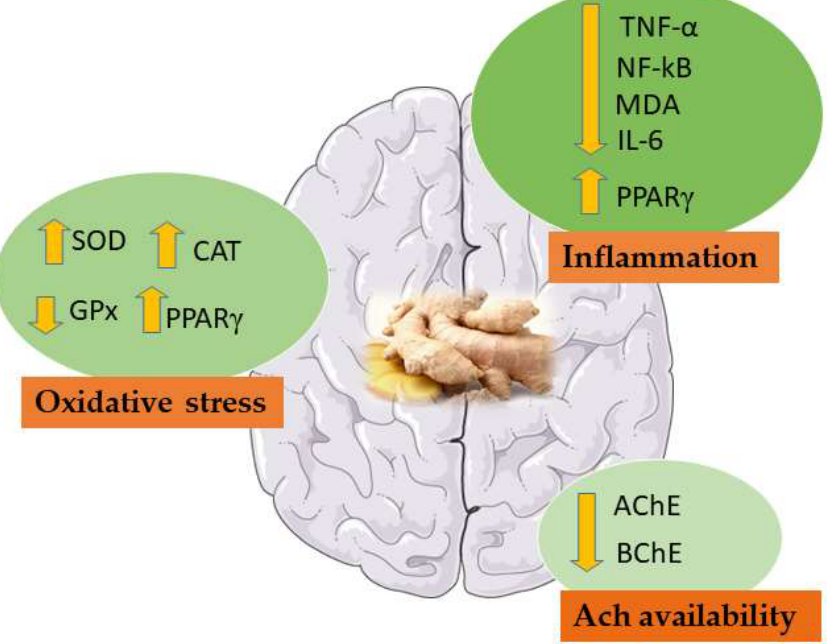
Figure 5. Main effects of ginger in VD studies. NF-κB: Nuclear factor kappa-B; MDA: Malondialde-